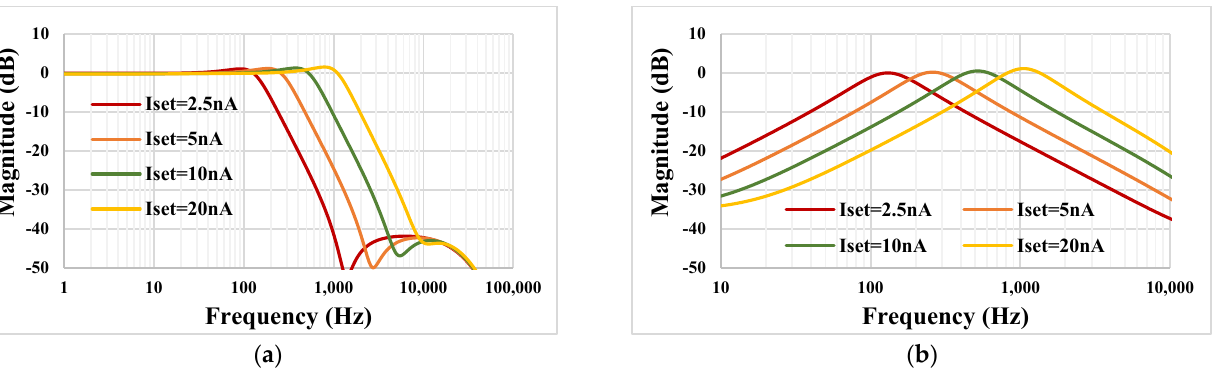
Figure 9. The simulated frequency characteristics showing the tuning capability of the LP ( a ) and BP filters ( b ).